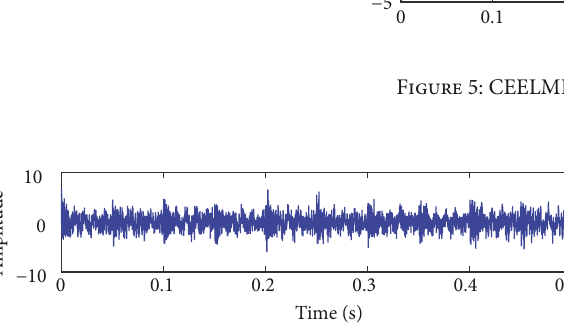
Figure 6: Simulation signal after adding